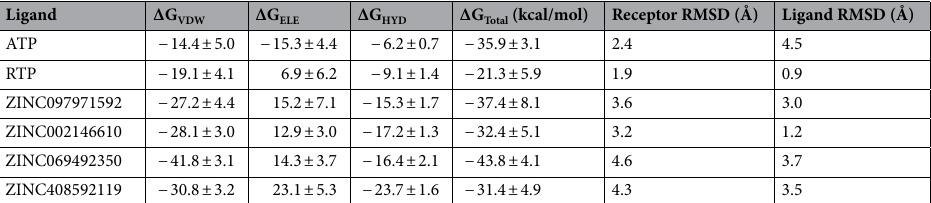
Table 3. MM-GBSA energy values and the average receptor/ligand RMSD from the last 50 ns of 1000 ns simulation time. VDW energies was calculated with the summation of ligand ΔG vdW energies, pi–pi packing correction energies and the self-contact correction energies. Electrophilic terms are calculated by the summation of coulombic, hydrogen-bonding and generalized born electrostatic solvation energies. Hydrophilic term comprised of lipophilic energies. Total MM-GBSA (ΔG Total ) calculated in kcal/mol is summation of ΔG vdW , ΔG ele and ΔG hyd